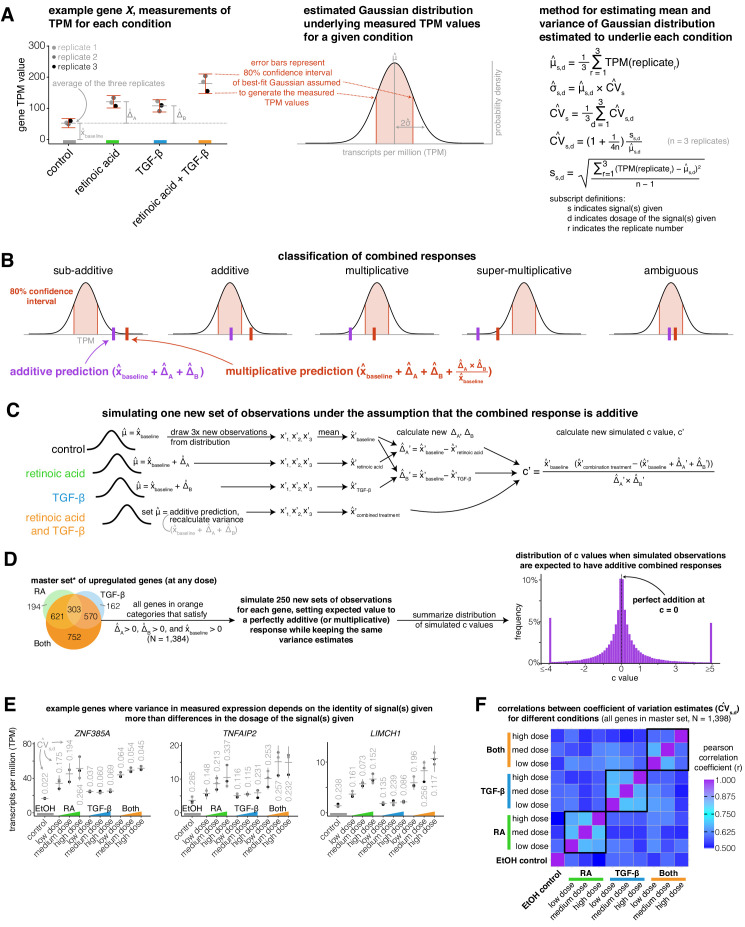
Explanatory schematics for model of gene expression variation, classification of combined responses, and simulating new additive or multiplicative combined responses.(A) Schematic illustrating how we estimate the 80% confidence interval of a Gaussian distribution underlying our gene expression measurements. (B) Illustration of how we use the 80% confidence interval to classify combined responses in Figure 1E as sub-additive, additive, multiplicative, super-multiplicative, or ambiguous. (C) Diagram showing how we simulate new observations by using the Gaussian distributions we estimated to underlie each condition and dose’s gene expression measurements. (D) Schematic showing how we combine many simulated combined responses from each gene in our master set (*less any gene with a control TPM measurement of 0) to create a new distribution of simulated c values. (E) Example genes illustrating how the variance of a gene expression measurement often depends on the signal(s) given. (F) Correlation matrix showing the Pearson correlation between coefficient of variation (CV) estimates between each condition, with black boxes outlining correlations between different doses of the same signal(s).